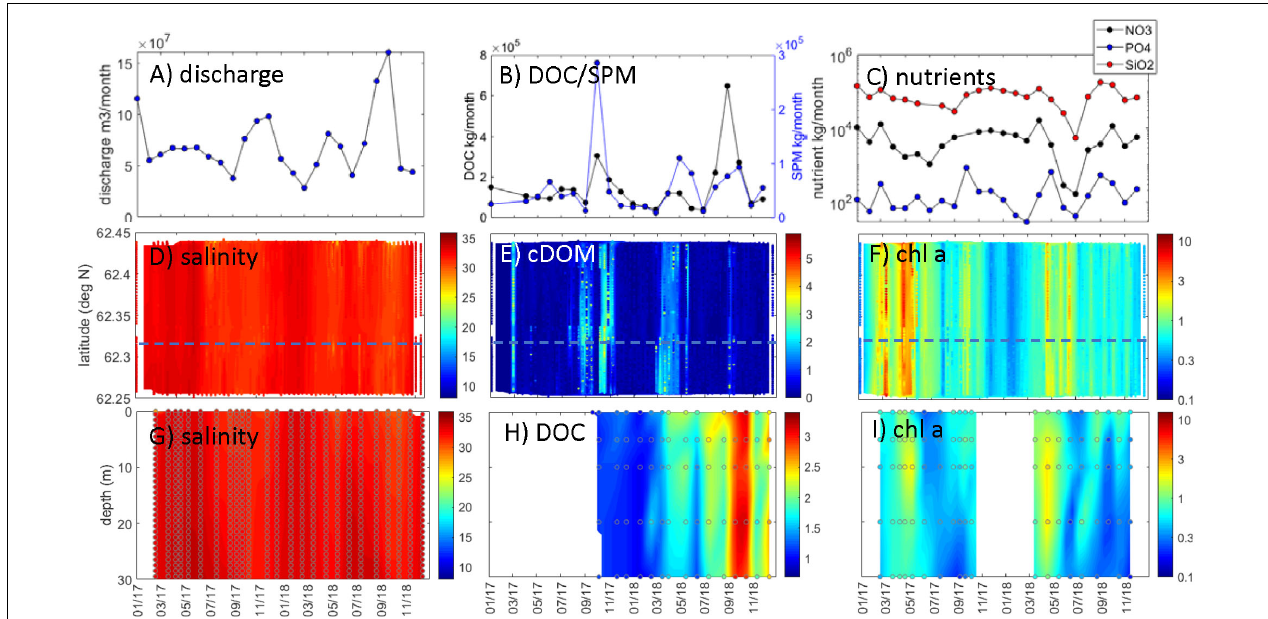
FIGURE 5 | Runde/western Norway observations. Nausta river: (A) discharge (m 3 month − 1 ), (B) DOC transport (kg month − 1 ) and SPM transport (kg month − 1 ), and (C) nutrient transport (kg month − 1 ; black: NO 3 -N, blue: PO 4 -P, red: SiO 2 -Si). FerryBox observations within < 1 km of coastal station: (D) salinity, (E) cDOM fluorescence (arbitrary), and (F) chl a ( µ g L − 1 ; log scale). Water column station data [comparable latitude indicated by dashed blue line in panels (D–F) ]: (G) salinity, (H) DOC (mg L − 1 ), and (I) chl a ( µ g L − 1 ; log scale). Data in panels (D–I) were interpolated with actual data points superimposed.